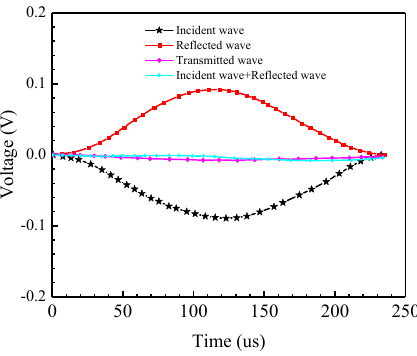
Figure 5. Stress equilibrium diagram.